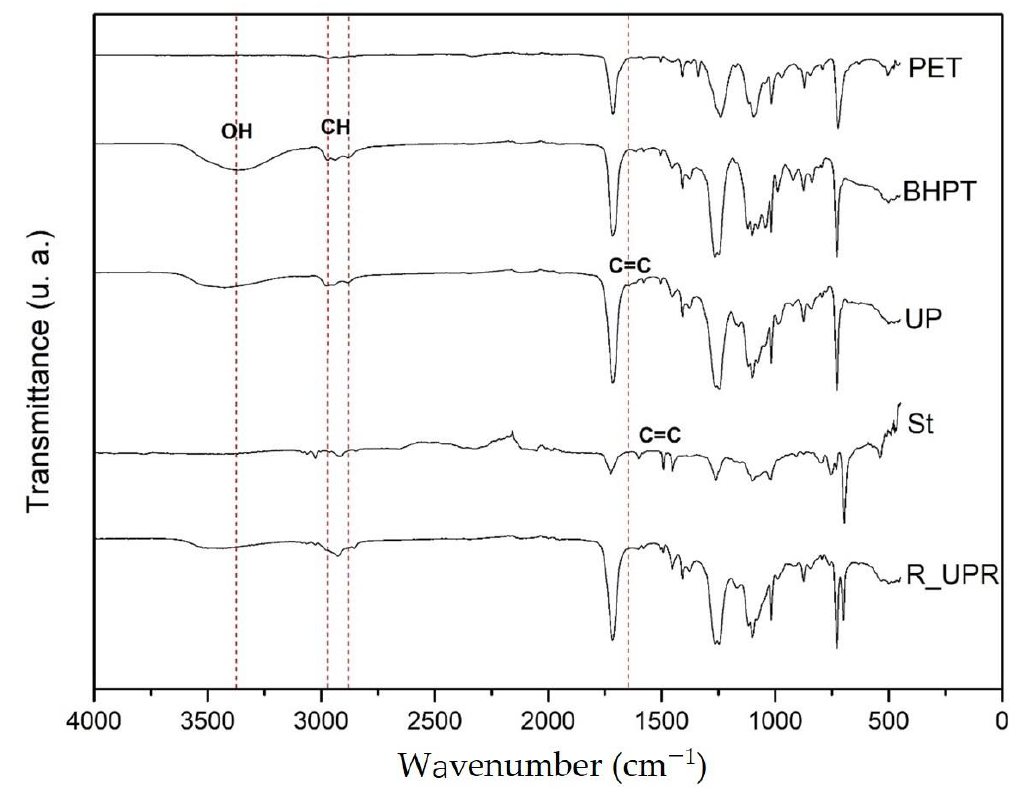
Figure 1. The FT-IR spectra of PET, BHPT, UP, St, and R-UPR.